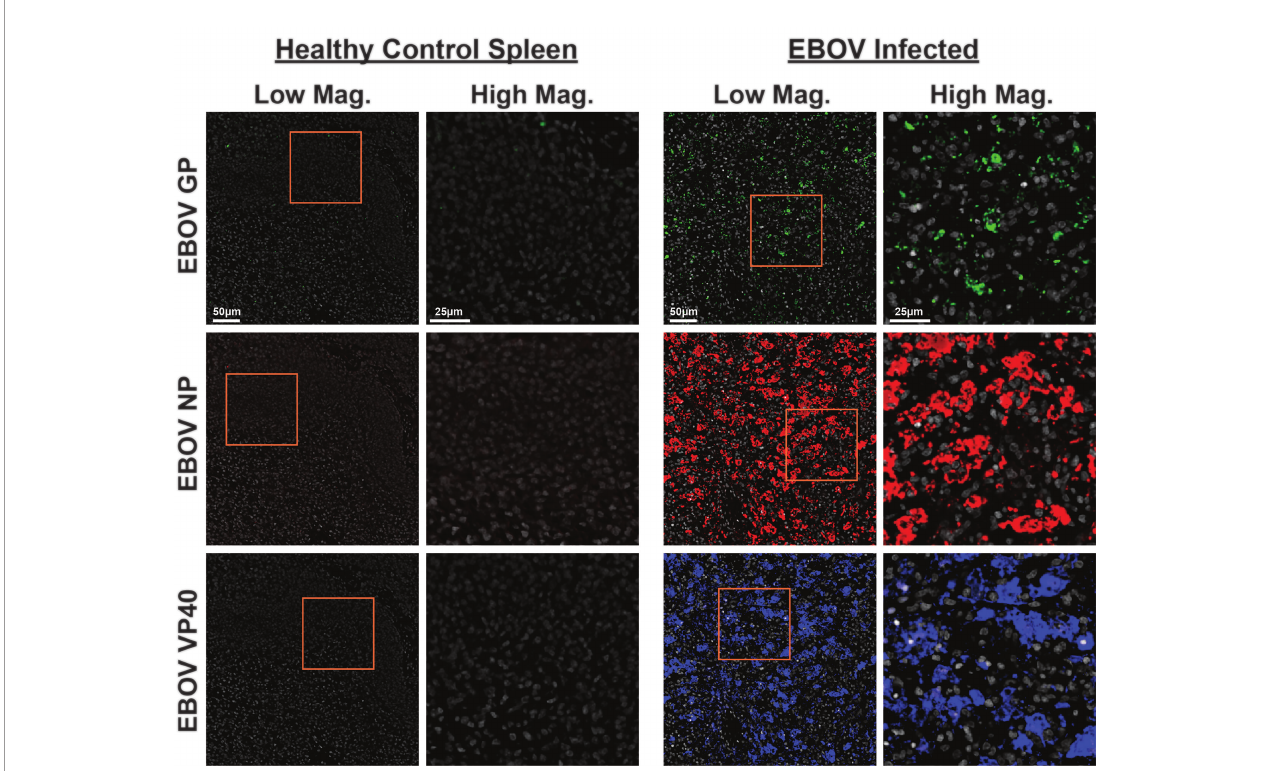
FIGURE 6 | CODEX validation of anti-EBOV protein antibodies. Representative low magni fi cation (left, center right) and high magni fi cation (center left, right) CODEX images for indicated EBOV protein markers on healthy control spleen sections (left) or spleen sections from EBOV challenged animals (right). EBOV GP (green), EBOV NP (red), EBOV VP40 (blue). Inlaid orange boxes on low magni fi cation images indicate the magni fi ed